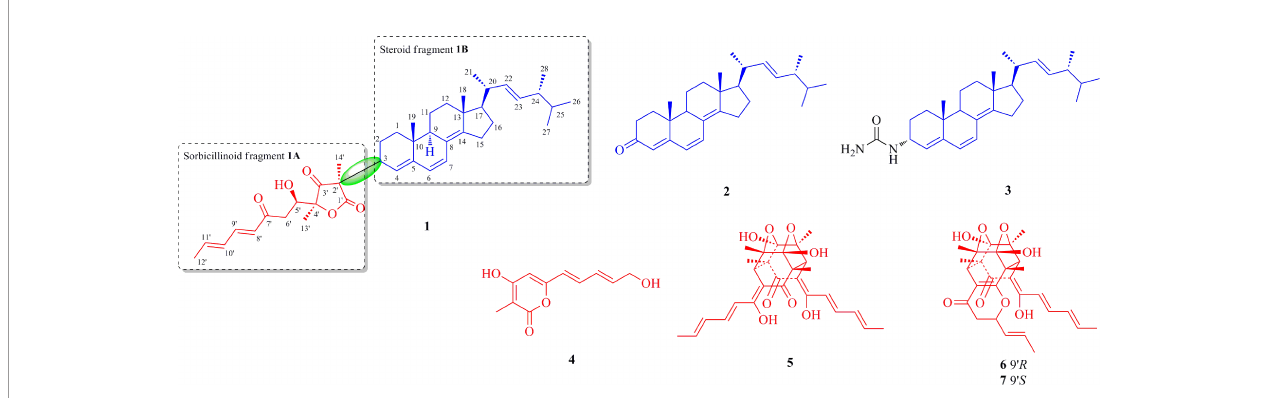
FIGURE 1 | Chemical structures of compounds 1 – 7